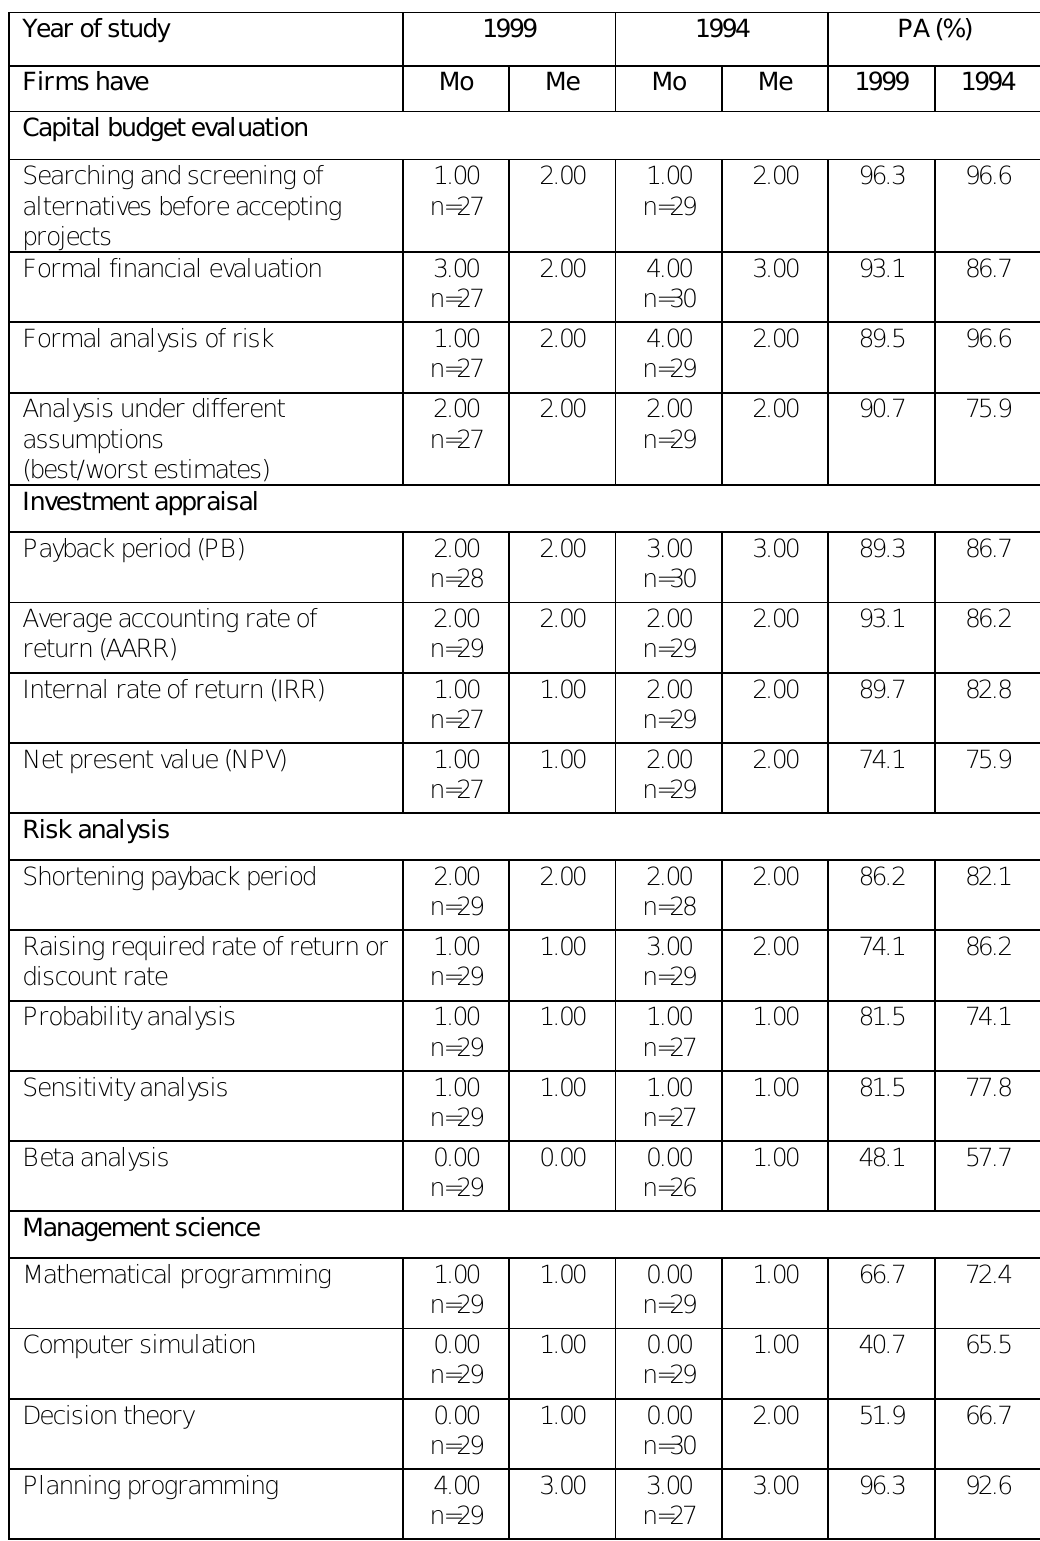
Table 7: Comparisons of 1999 and 1994 surveys Year of